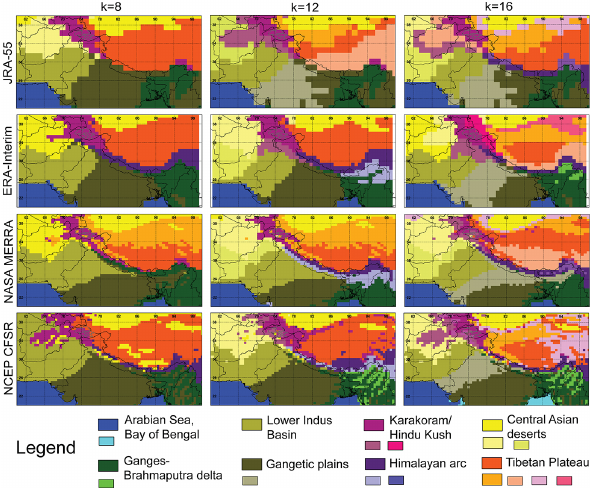
Figure 5. Comparison of climate classifications resulting from the use of 8, 12 and 16 clusters ( k ) on principal components from the individual reanalyses. Large units in the legend refer to zones for the k = 8